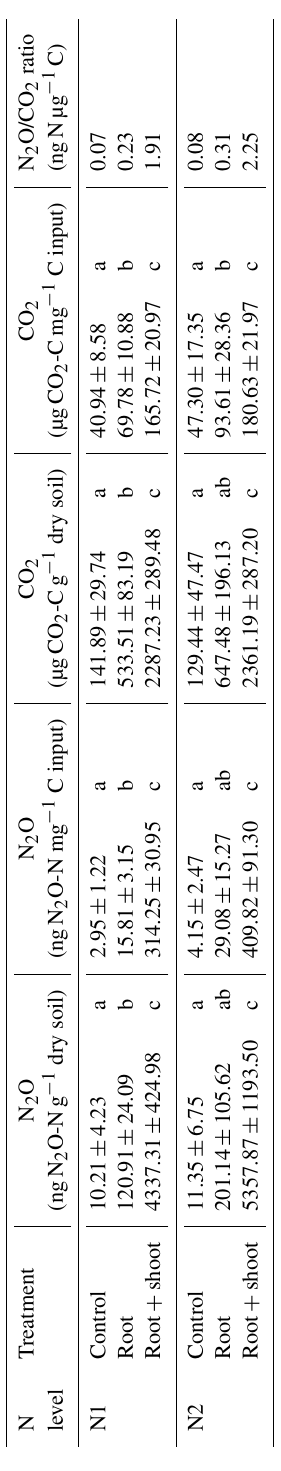
Table 4. N mineralization during the incubation period. N Treatment N mineralized during incubation